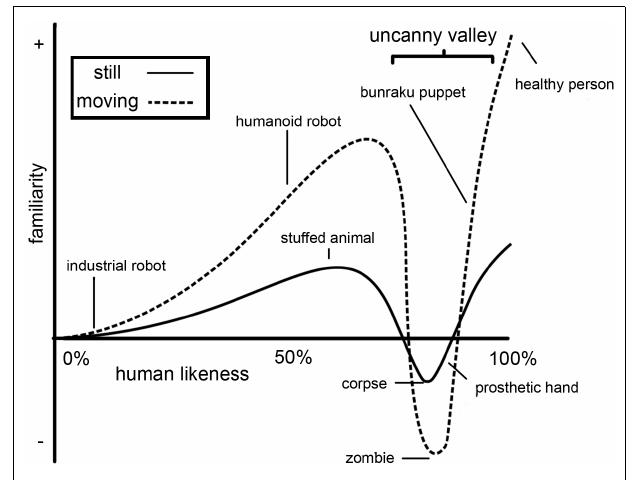
FIGURE 1 | Illustration of the “uncanny valley” function, shown as a simplified version of the figure appearing in Mori’s (1970) original Energy article from the translation by MacDorman and Minato (MacDorman,